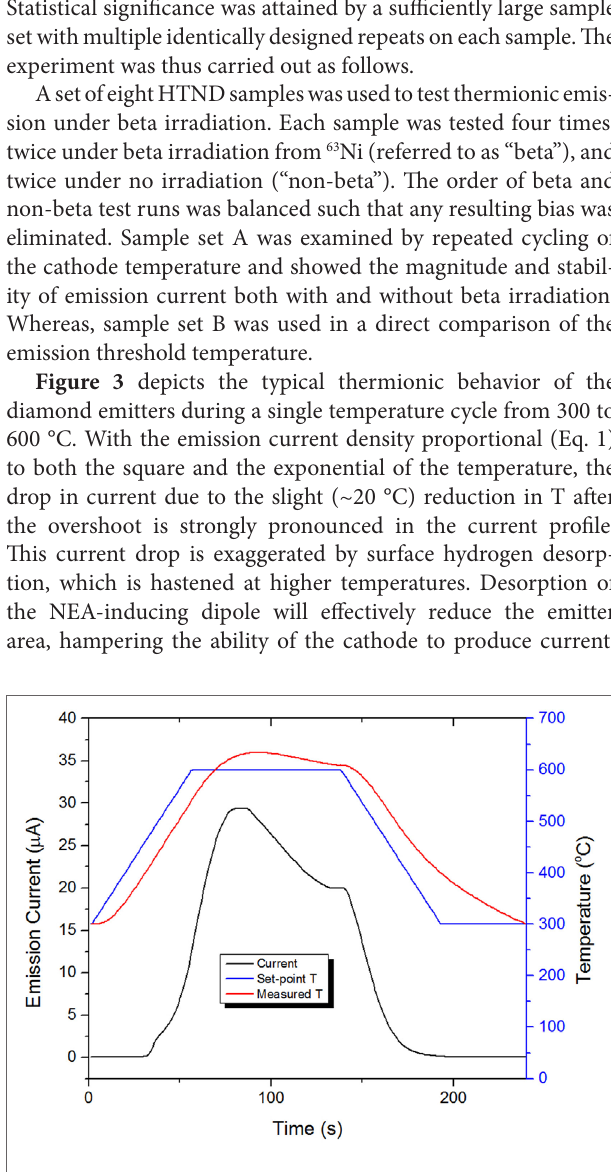
FigUre 2 | Representative material characterization data for the diamond emitter surface. Both Raman spectra (a) and scanning electron micrographs (B) were consistent across the sample